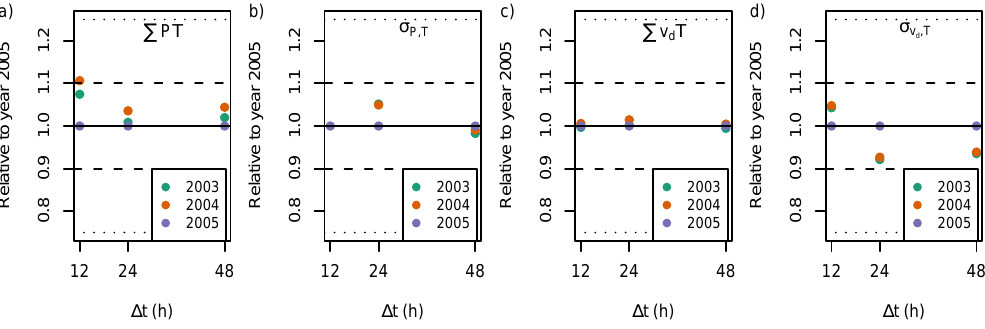
Fig. 8. Annual variability for catchment area parameters (a) population sum P P T , (b) population variability σ P,T , (c) deposition sum P v d T and (d) deposition variability σ v d ,T as derived for the site Hohenpeissenberg (HPB) and the period